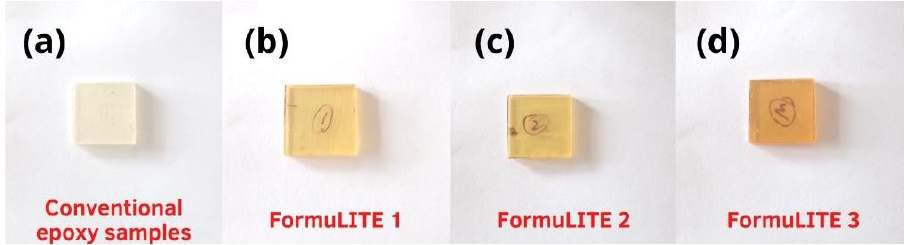
Figure 5. Hardness test specimen dimension as per ASTM E92-17 standard, ( a ) conventional epoxy, ( b ) FormuLITE 1, ( c ) FormuLITE 2, and ( d ) FormuLITE 3.